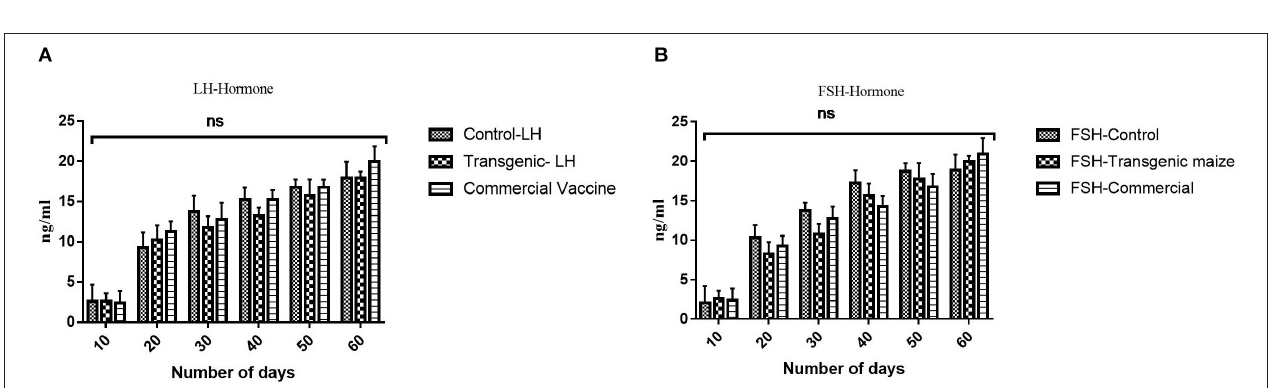
FIGURE 9 | Serum specific IgY response against F protein. F specific Serum IgY immune responses in Chicken immunized with transgenic maize leaves. Groups of 18 days old chicken were immunized on day 0, 10, 20, 30, 40, 50, and 60. IgY level against F protein was slightly less as compared to the to the chicken vaccinated through injection of recombinant F protein from E. coli and commercially available vaccine against NDV while no immunogenic response was observed in group receiving non-transgenic corn. Data shown are average ± SD ( n = 5/group). The significance of the data is determined by one-way ANOVA and p < 0.0001 is indicated by “****” above bars whereas “ns,” non-significant.